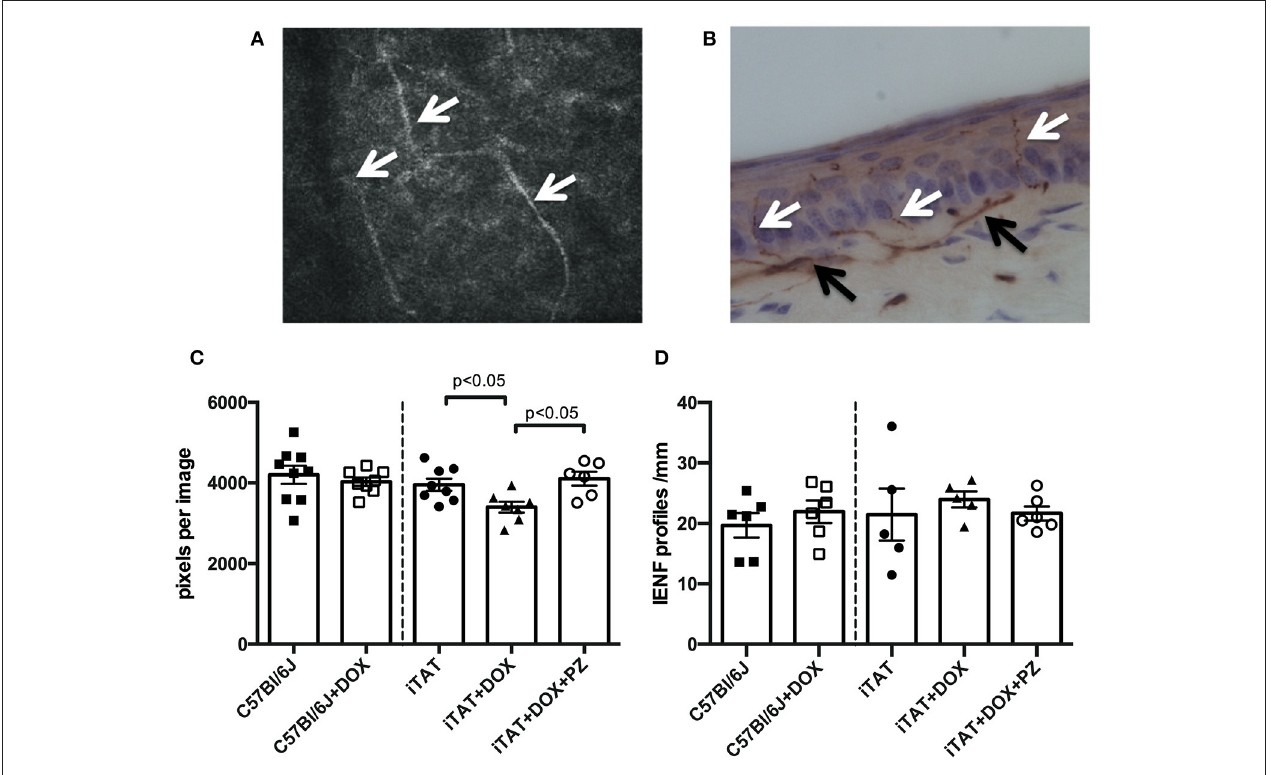
FIGURE 3 | Sensory nerve structure. (A) Representative image of mouse corneal sub-basal nerves (white arrowheads). (B) Representative image of mouse paw skin dermal (black arrowheads) and intra-epidermal (white arrowheads) PGP9.5 + ve nerves. (C) Corneal nerve density in C57Bl6/J mice treated with vehicle or DOX and in TAT transgenic mice treated with vehicle, DOX or DOX and PZ. (D) Intra-epidermal nerve fiber density of C57Bl6/J mice treated with vehicle or DOX and of TAT transgenic mice treated with vehicle, DOX or DOX and PZ. Data are group mean of N = 5–9/group ± SEM. Statistical comparisons by unpaired t test (left sub-panel) or one-way ANOVA followed by Tukey’s post-hoc test (right